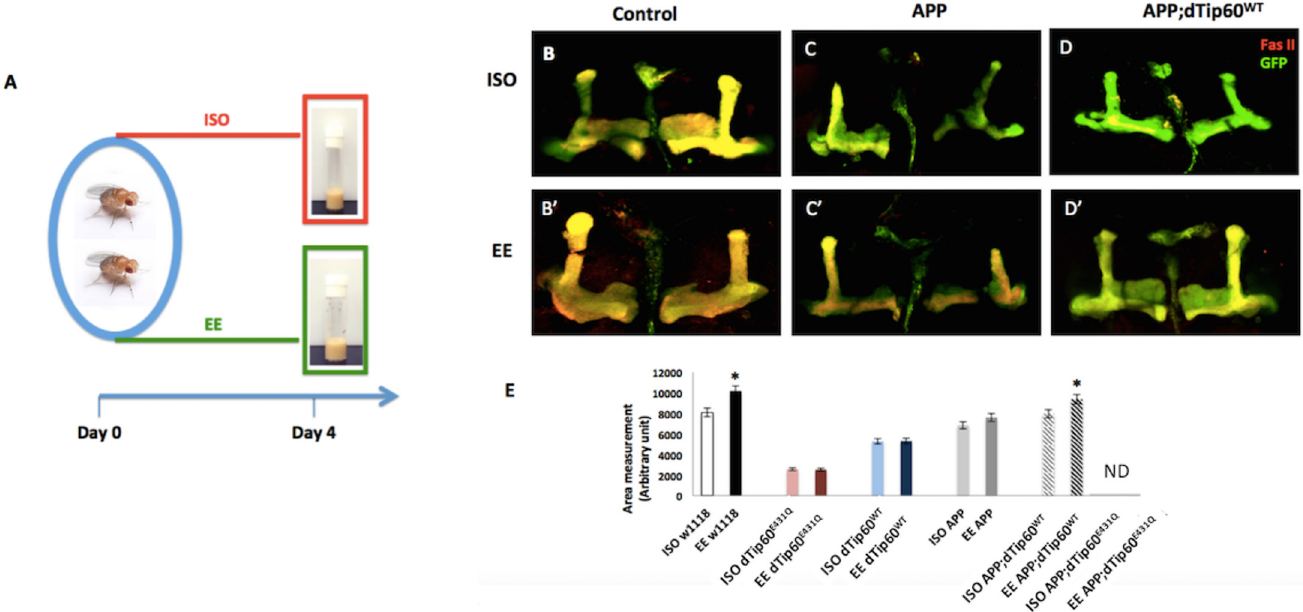
Fig 1. Tip60 HAT activity restores EE mediated neuroadaptive benefits on MB morphology under APP neurodegenerative conditions. (A) Experimental paradigm for flies exposed to isolation (ISO) or environmental enrichment (EE) conditions. Newly eclosed adult fly progeny were exposed to a group of 30 flies (1:1 sex ratio) (EE), or housed individually (ISO) for 5 days. (B-D) Representative confocal images of adult MB visualized by mCD8-GFP and stained with axonal marker Fascillin II (Fas II) antibody from 5-day old adult fly expressing indicated transgenes driven by GFP;; OK107-Gal4 under ISO or EE condition. Anti-GFP staining used as marker to delineate MB in the adult brains. Anti-Fas II staining shows a/ß and r lobes in wild-type, APP and APP;dTip60 WT flies under ISO condition. (B ’ -D ’ ) Same genotype flies in EE condition. (E) Quantification of area in the different genotypes and housing conditions in adult flies. Data represent the mean of 15 replicates with error bars depicting 95% confidence interval. Student t-test was used to determine statistical significance between different housing conditions within the same genotype. APP;dTip60 E431Q flies exhibited severely malformed MB structure and lack of structural consistency, and therefore are labeled as ND (non-determined) in the quantification. ** P < 0.01, * P < 0.05.